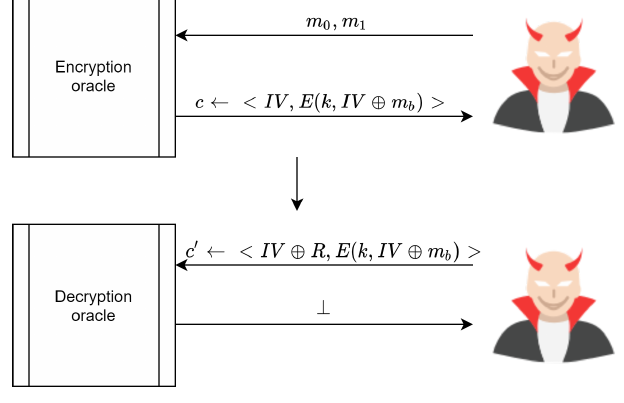
Figure 26. Proposed scheme IND-CCA